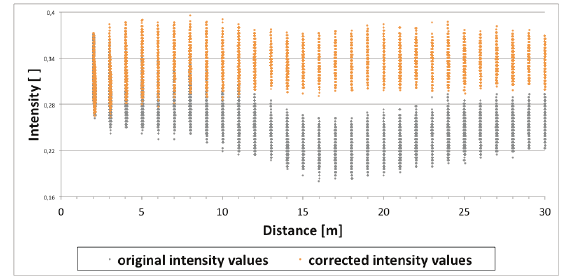
Figure 11. Correction of raw intensity values of the standard target (Riegl,